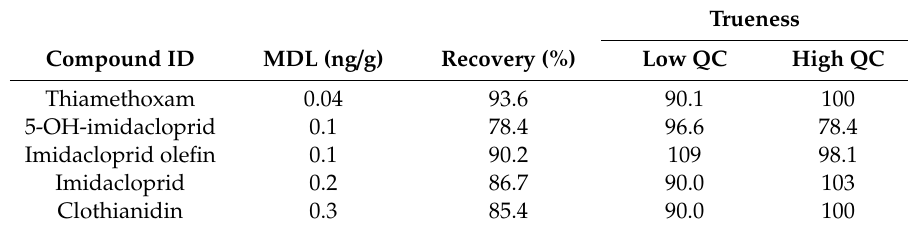
Table 2. Method detection limit (MDL), recovery, trueness, and matrix e ff ect for five target analytes in a common milkweed leaf matrix .